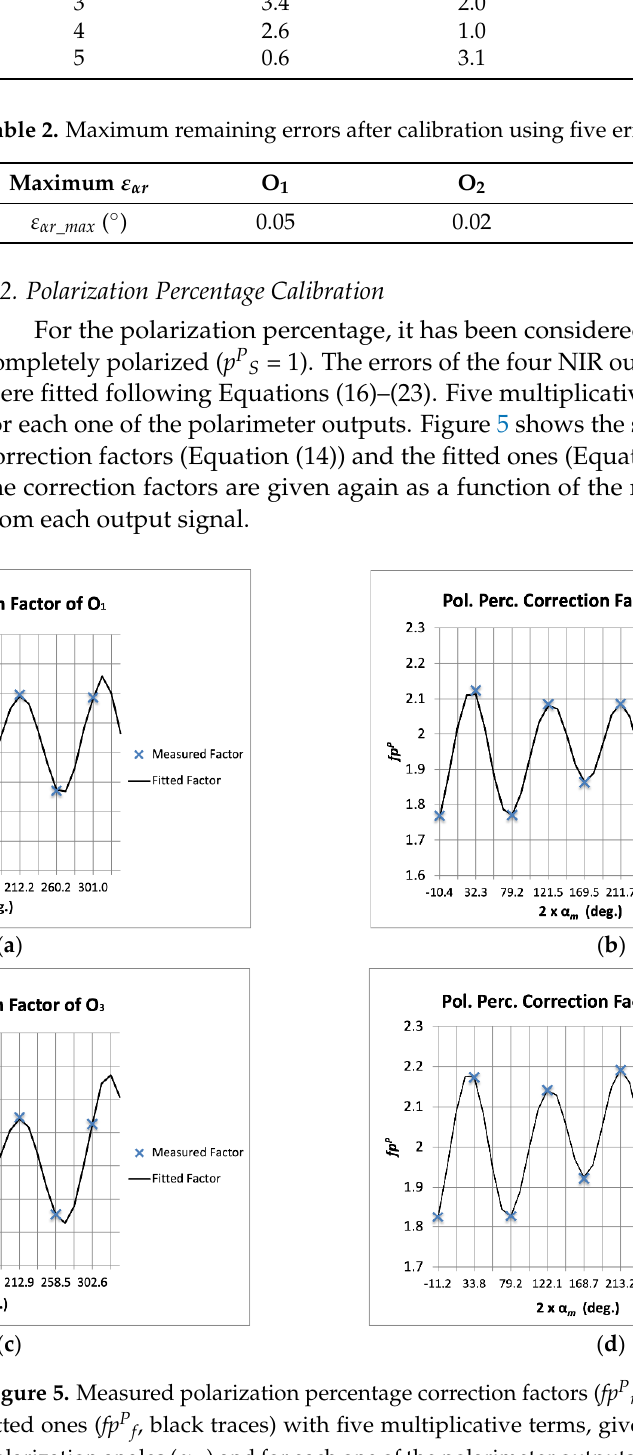
Table 2. Maximum remaining errors after calibration using five error terms.